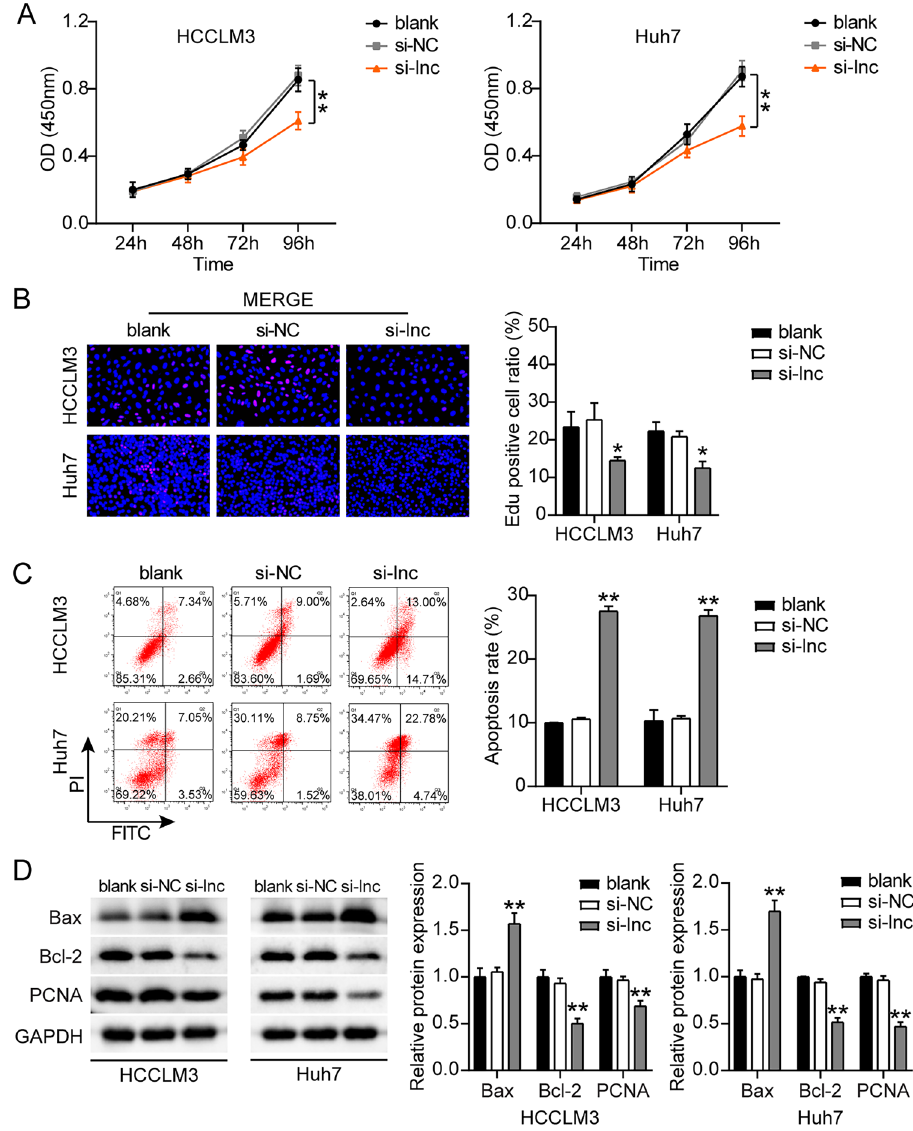
Figure 3. ST8SIA6-AS1 facilitated cell growth of LIHC cells. ( A ) Cell viability determined by CCK8 assay. ( B ) Detection of cell growth by the EdU assay. ( C ) The FITC apoptosis detection kit was used to assess cell apoptosis. ( D ) The expression of Bax, Bcl-2, and PCNA proteins was measured using a western blot test. *P < 0.05, **P < 0.001 compared with blank. NC: negative control; blank: blank control; si-ST8SIA6-AS is siRNA- ST8SIA6-AS1, and the statistical value is P < 0.001** at which we test